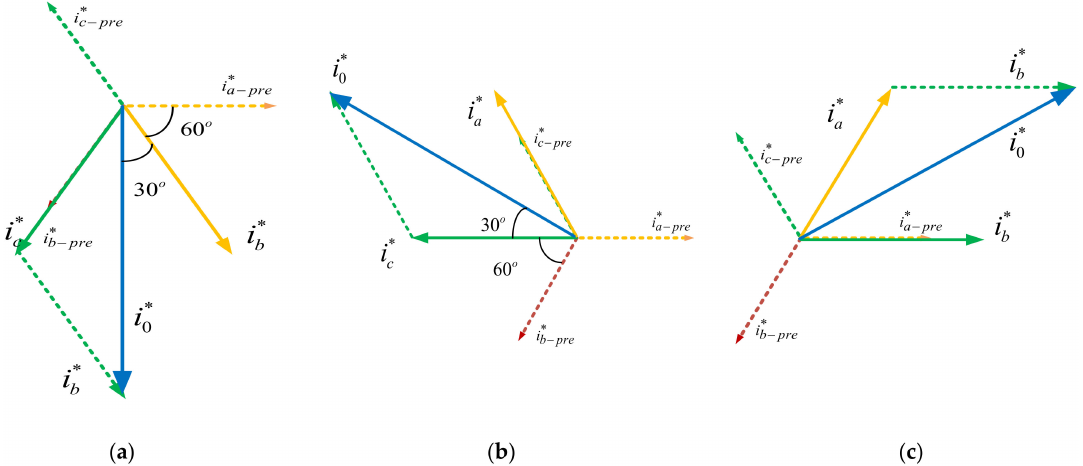
Figure 4. Non-fault phase reference current vector distribution in the case of fault. ( a – c ) Phase